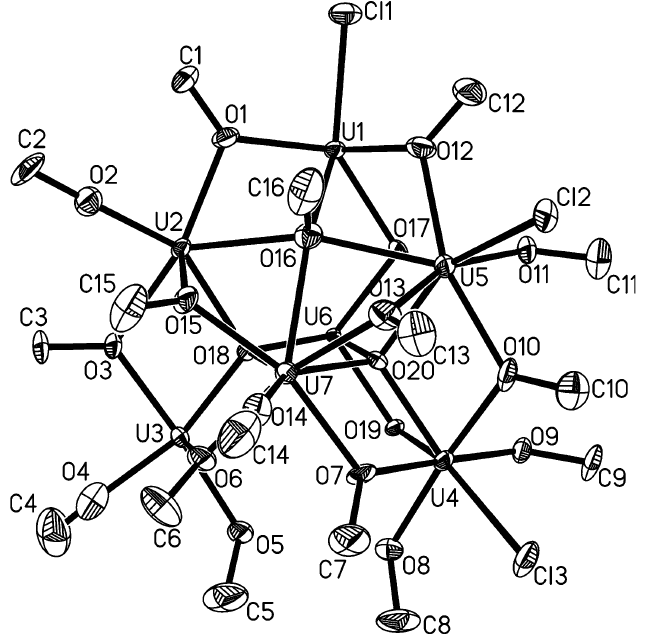
Figure 1 Molecular structure of the asymmetric unit of the {U 13 } cluster I . Ellipsoids are shown at the 50% probability level. H atoms are omitted for clarity, as are the disordered methoxide ligands (only the chlorides that share their locations are